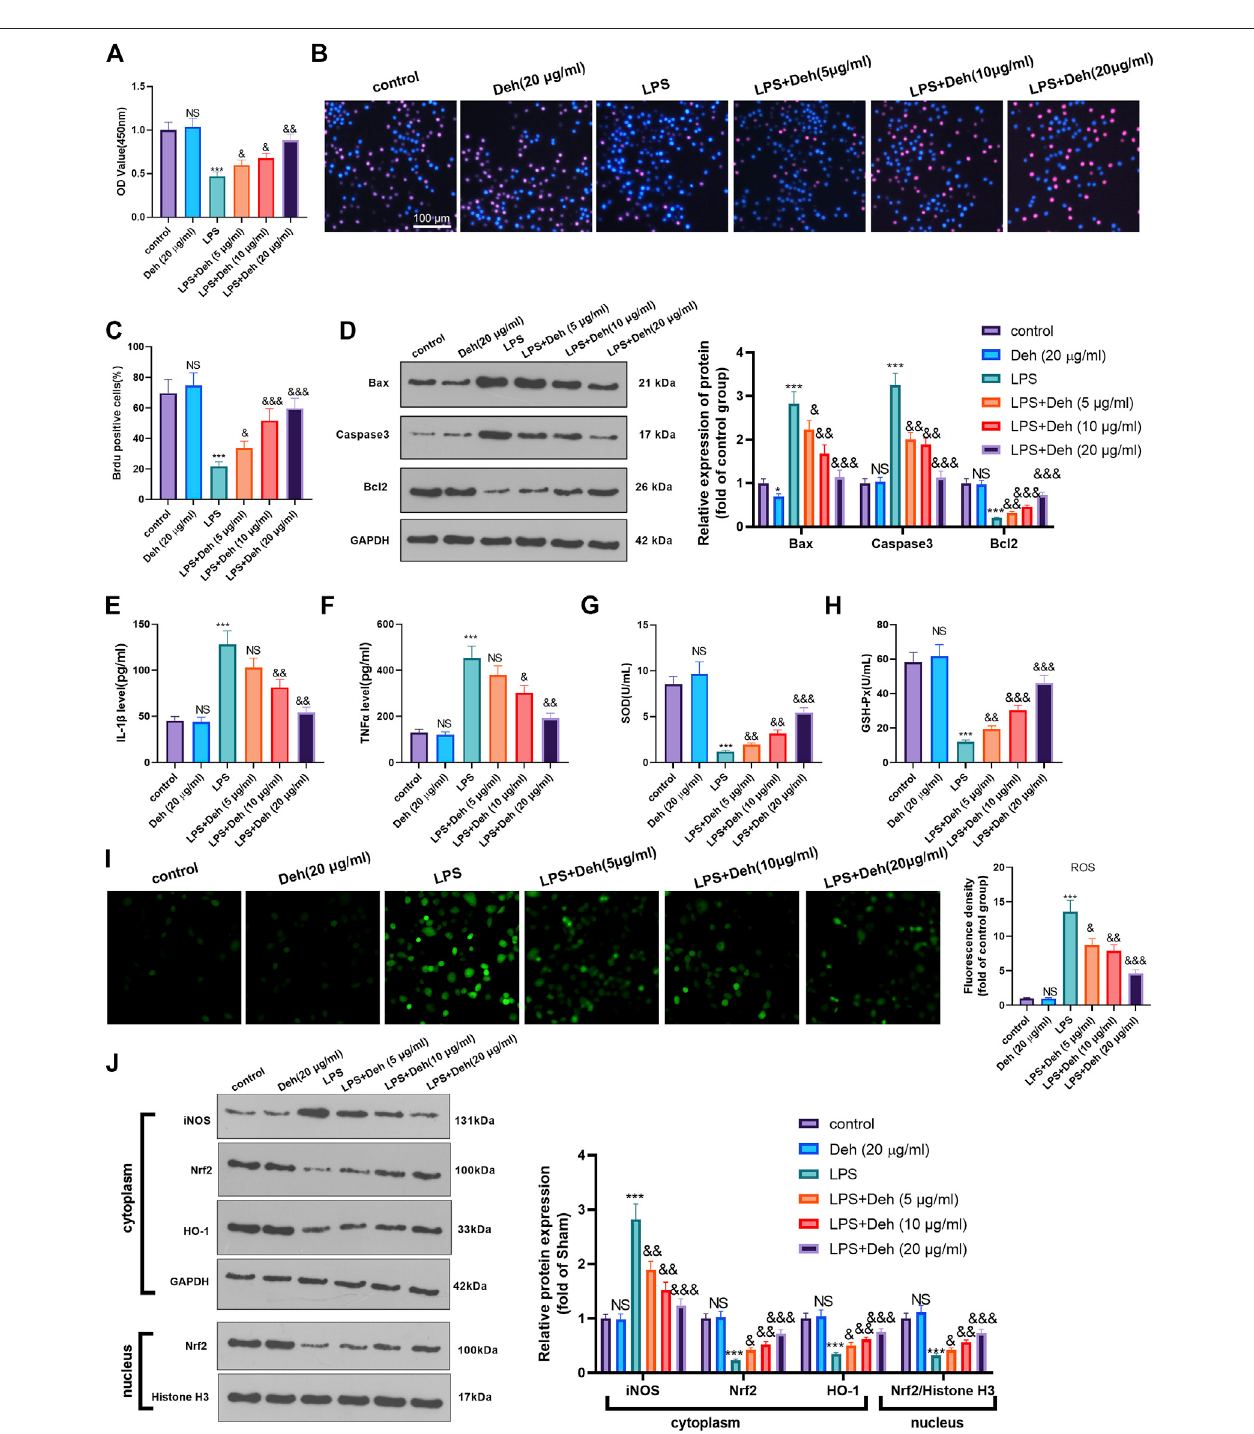
FIGURE 3 | Deh attenuated LPS-mediated H9C2 cell damage. The H9C2 cardiomyocytes were treated with LPS (10 μ g/ml) and/or Deh (5 – 20 μ g/ml) for 24 h (A, B) CCK8, and BrdU assay were taken to detect the cell viability of each group. (C) The rate of BrdU positive cells (red)/nucleus (blue) was calculated. (D) Western blot was performed for the detection ofBax,Caspase3and Bcl2expressions incardiomyocytes. (E, F) ELISA methodwas employedtoevaluateIL-1 β and TNF α levelsinthe culture mediumofeachgroup. (G,H) TheSODandGSH-PXdetectionkitswereappliedtodetectSOD (G) andGSH-PX (H) levelsintheculturemediumofeachgroup.I.The ROSlevelinH9C2cellswereevaluatedusingtheDCFDA/H2DCFDA — CellularROSAssayKit.J.TheproteinlevelofiNOS,Nrf2/HO-1inthewholecellornucleusofheartwas detected by western blot. NS p > 0.05, * p < 0.05, *** p < 0.001 (vs. control group); & p < 0.05, && p < 0.01, &&& p < 0.001 (vs. LPS group). N (cid:1) 3.